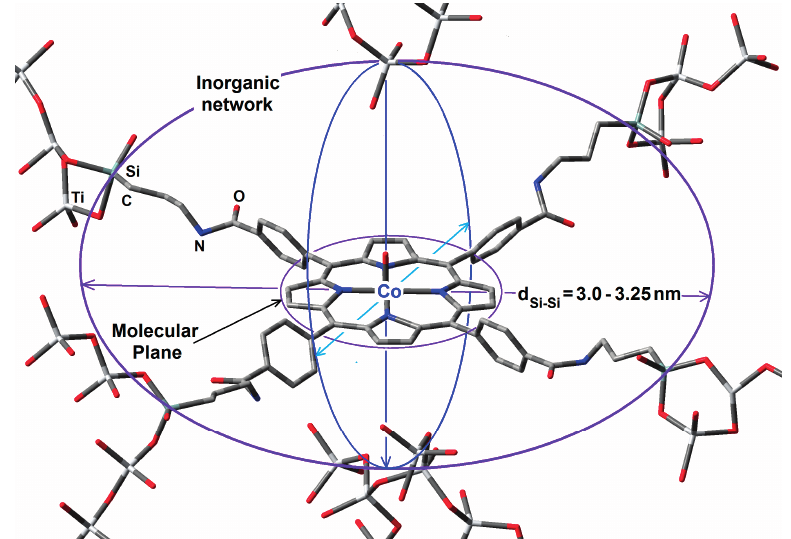
Figure 13. Hypothetical situation of the CoT( p- COOH)PP species bonded to the TiO 2 pore network by means of silicon precursory alkoxides, which restrains the growing of the network at the periphery of the trapped macrocycle without inhibiting the approaching of gelling particles at both sides of the molecular plane. Hydrogen atoms are omitted for